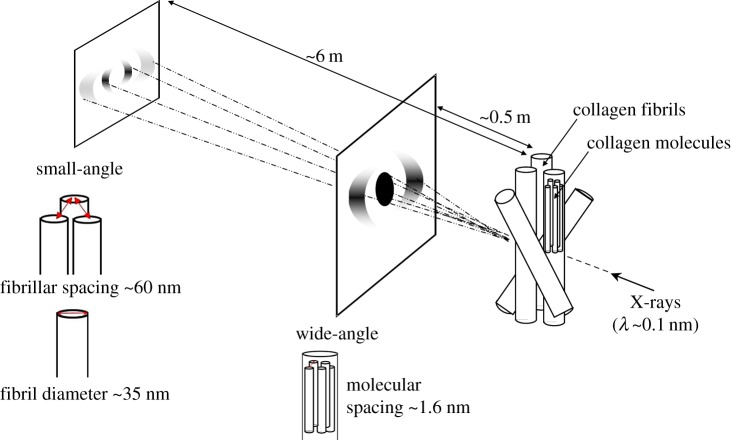
Schematic of corneal multi-modal X-ray scattering. X-rays are directed perpendicular to the corneal plane. The resulting X-ray scatter pattern is collected on a detector positioned behind the specimen. The distribution of small-angle X-ray scatter provides information about collagen parameters at the fibrillar level, whereas the wide-angle X-ray scatter provides information at the molecular level. (Online version in colour.)